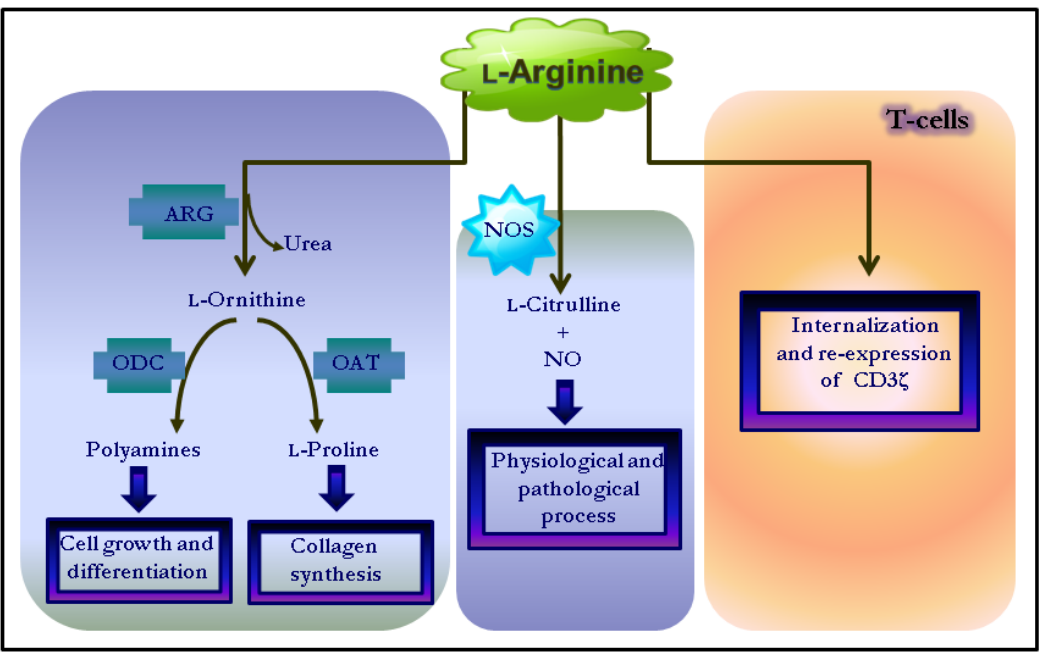
FIGURE 2. Schematic representation of the L -Arg metabolic pathways. The activities of the enzymes involved in L -Arg metabolism are illustrated together with the related function exerted by the final products. ARG and NOS compete for L -Arg disposal, and relative changes in their activities determine nitric oxide and polyamine production in many cell types. L -Arg is also involved in the internalization and re-expression of the T-cell receptor ζ chain.